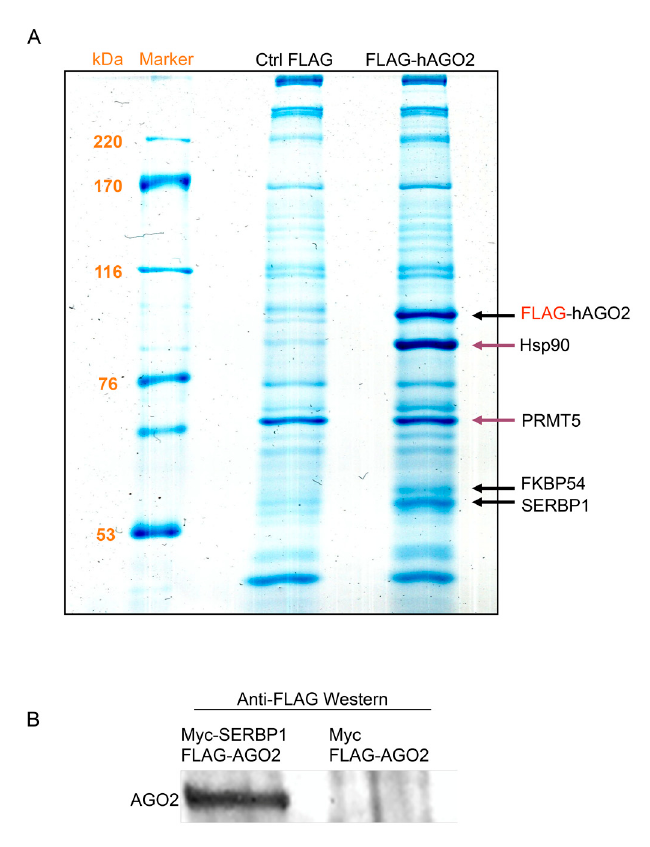
Figure 1. Ago2 interacts with SERBP1. ( A ) SDS-PAGE stained with Comassie Brilliant Blue of IP with FLAG antibody in SH-SY5Y stably expressing FLAG (lane 1) and FLAG-Ago2 (lane2). Bands corresponding to Ago2-associated proteins are indicated. ( B ) Cells were co-transfected with Myc- SERBP1 and Flag-Ago2 (lane 1) or with Myc and Flag-Ago2 as the negative control (lane 2) and immunoprecipitation was performed with anti-Myc antibody conjugated beads. Flag-Ago2 was detected by Western blot using anti-FLAG monoclonal antibody.